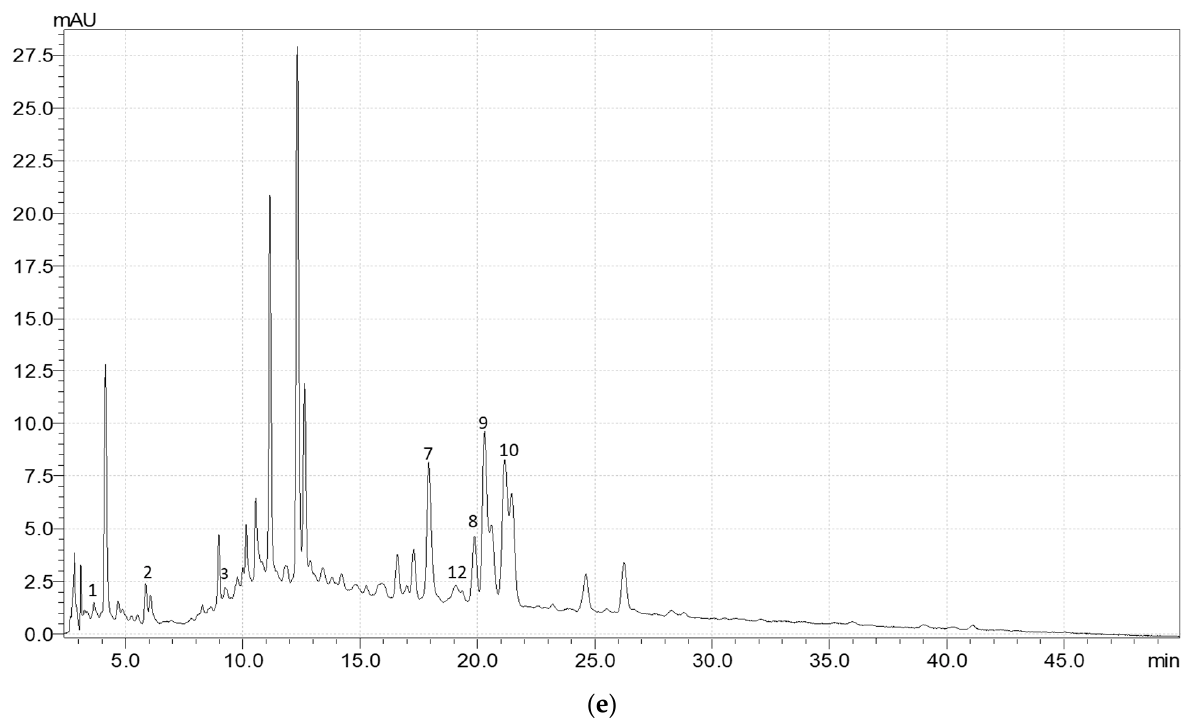
Figure A1. Exemplary HPLC chromatogram (at 340 nm) of the phenolic acids and flavonoids in ( a ) the upper leaves, ( b ) upper stems, ( c ) flowers, ( d ) fruits, and ( e ) roots of meadowsweet ( Filipendula ulmaria (L.) Maxim.). 1—gallic acid; 2—3,4-dihydroxybenzoic acid; 3—caftaric acid; 4—catechin; 5—chlorogenic acid; 6—p-coumaric acid; 7—ellagic acid; 8—rutin; 9—isoquercitrin; 10—cynaroside; 11—astragalin; 12—salicylic acid; 13—caffeic acid; 14—spiraeoside.